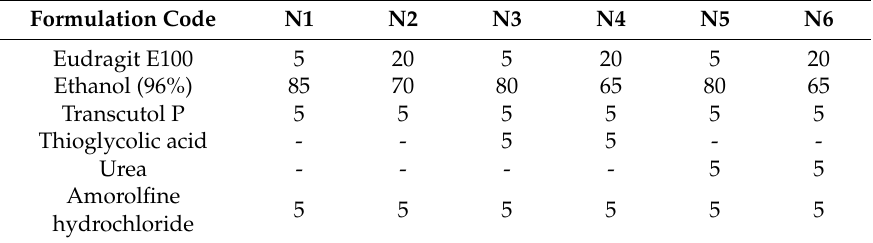
Table 1. Compositions of formulated experimental lacquers with amorolfine hydrochloride. Formulation Code